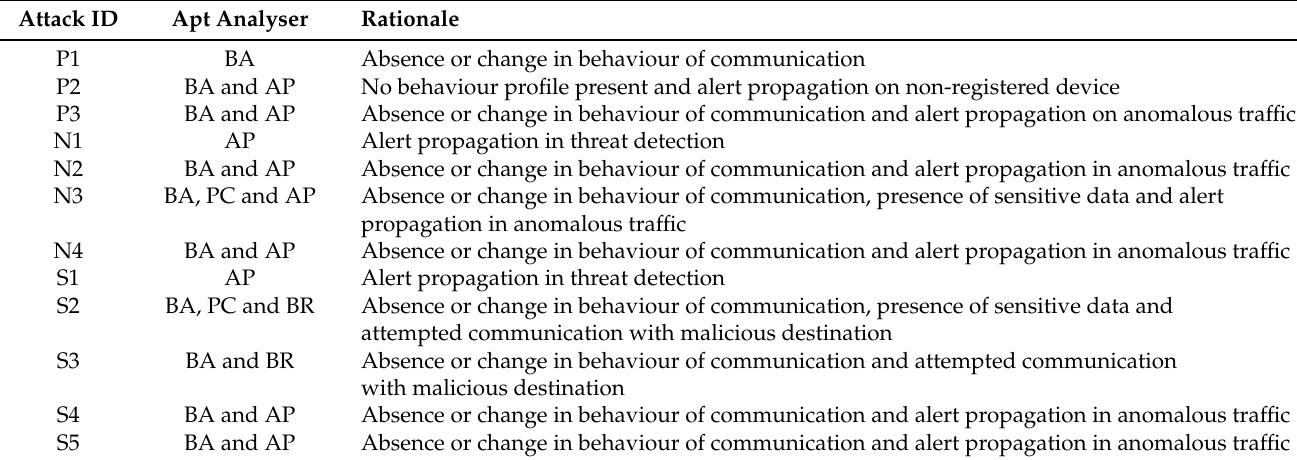
Table 7. Attack and analyser